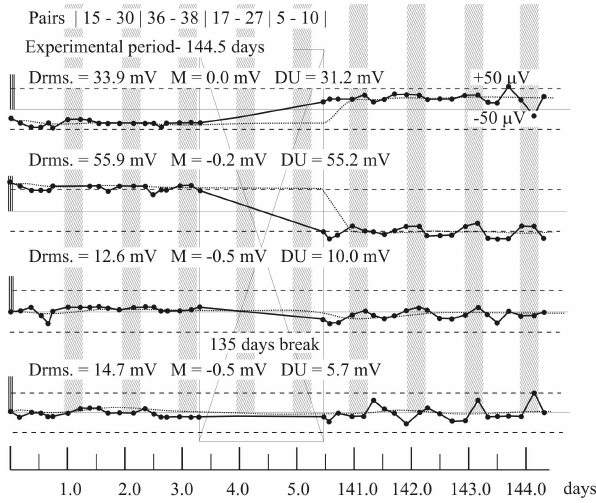
Figure 2. Long-term drift of the potential difference of selected pairs of electrodes. Here: Drms – root mean square error; M – zero line shift. DU is averaged for 1-day dispersion.